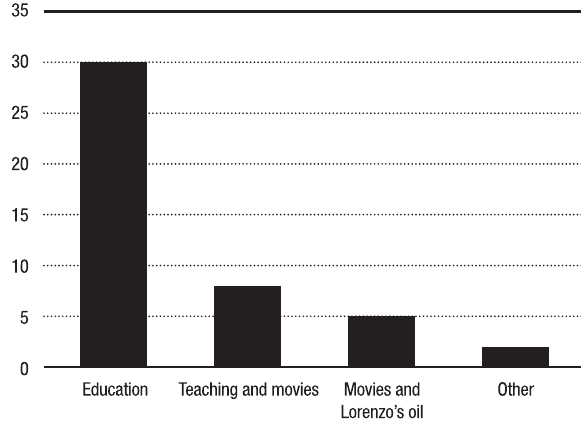
Figure 1. Number of papers/books related to the subject of this